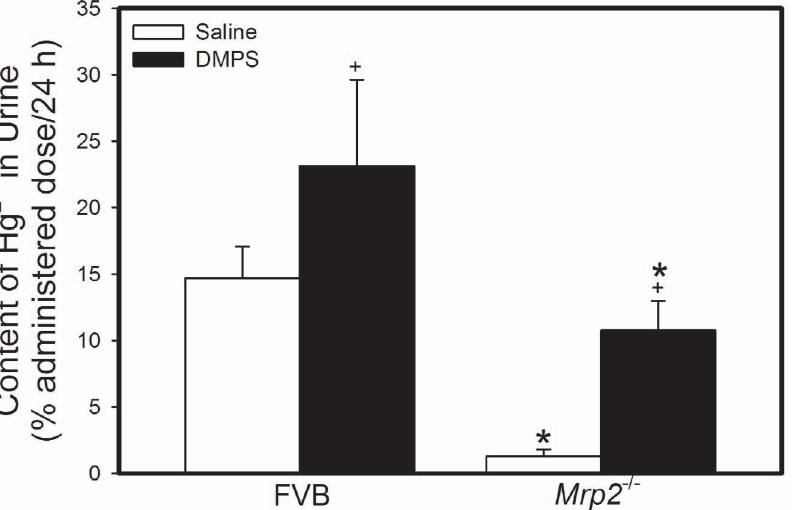
Figure 4. Content of Mercury in Urine of Mrp2 2 / 2 and FVB Mice. Mrp2 2 / 2 and FVB mice were injected intraperitoneally with a dose of 0.5 m mol ? kg 2 1 ? 8 mL 2 1 HgCl 2 . Urine was collected 24 h and 48 h after injection with HgCl 2 . Data represent mean 6 SE of urine collected from four mice. *, significantly different from mean of corresponding FVB mice (p , 0.05). + , significantly different from mean of mice from same strain treated with saline (p ,